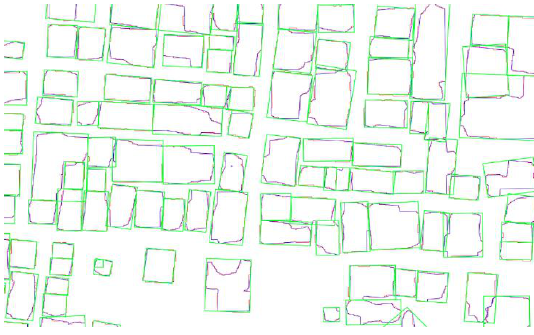
Figure 2 . 6 : Red - Noisy vector, Blue - Simplified vector Green - Minimum Bounding